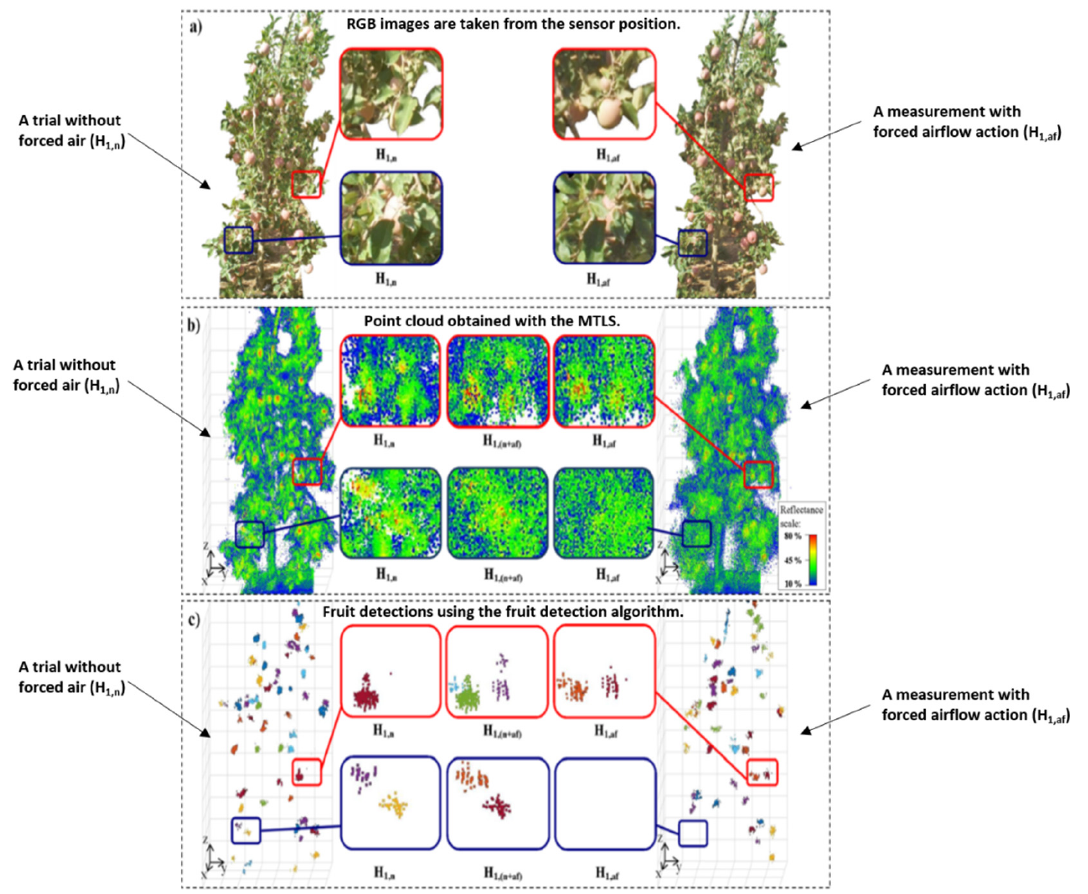
Figure 8. Illustration of the forced airflow effect in fruit detection. Reprinted with permission from Ref. [52] Copyright 2019 Elsevier. Table 8 . Comparison of various aspects of LiDAR data in yield prediction.